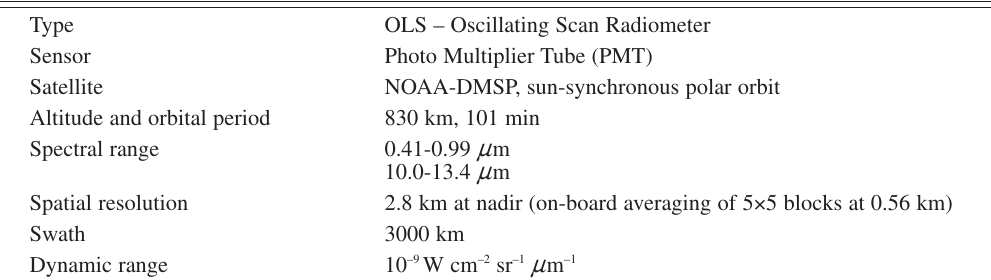
Table I. Main properties of the DSMP-OLS instrument used for the remote assessment of light pollution.